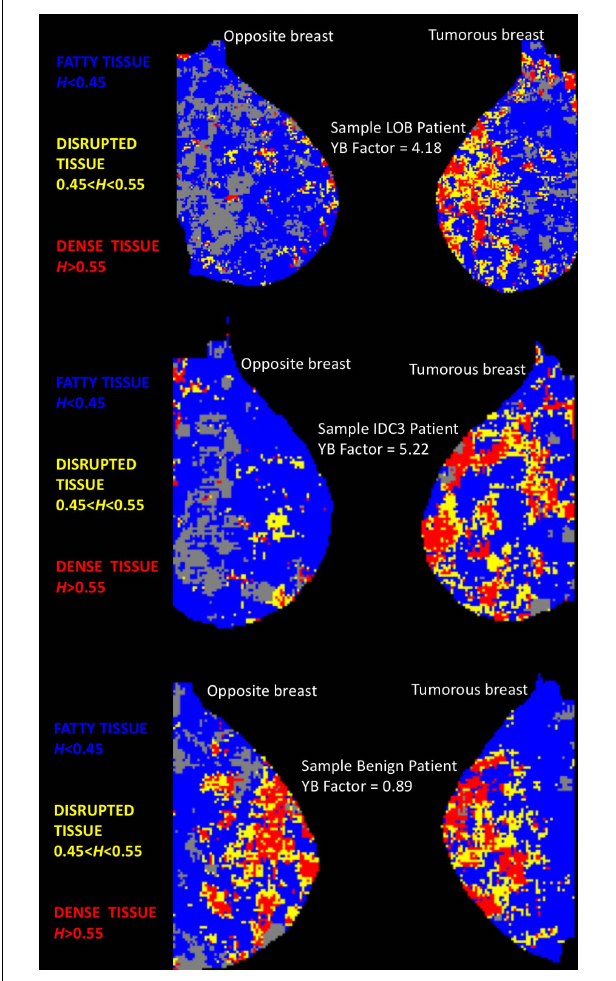
FIGURE 1 | Color-coded MLO views of the tumorous and opposite breast from three sample patients. Each pixel represents “a 360 × 360-pixel mammogram subregion colored according to its H value. Subregions where H ≤ 0.45 (fatty) are colored blue, 0.45 < H < 0.55 (disrupted) are yellow, and H ≥ 0.55 (dense) are red. Gray pixels correspond to rejected subregions” [see (Marin et al., 2017)]. TOP: Patient with an invasive lobular carcinoma. MIDDLE: Patient with an invasive ductal carcinoma. BOTTOM: Patient with a benign lesion (fibrocystic mastopathy). For the two cancer patients, the two MLO panels show evident differences in terms of yellow (disrupted tissue, 0.45 < H < 0.55) subregions. However, for the benign patient, both breasts do not display evident visual differences in tissue